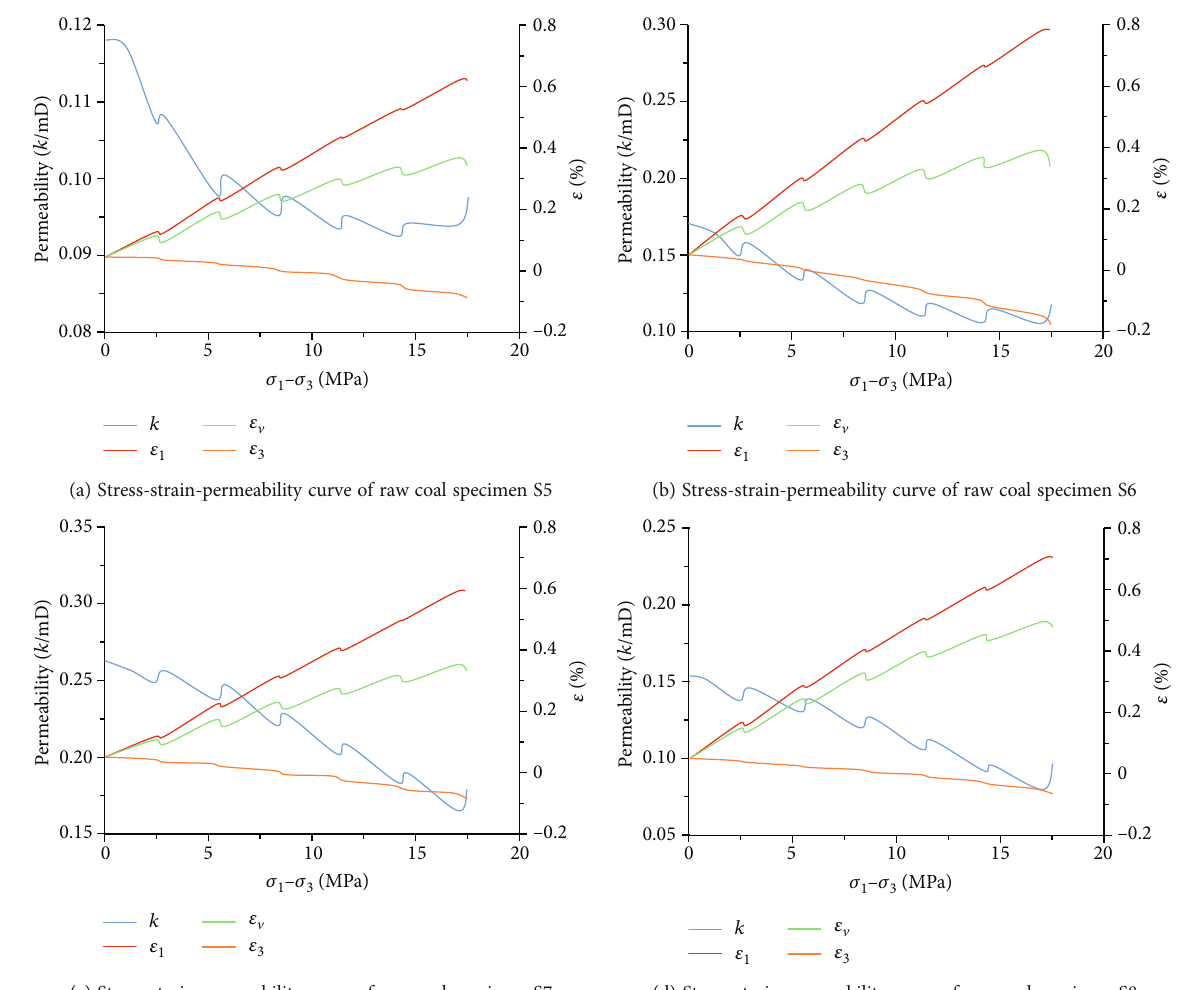
Figure 5: Stress-strain-permeability curve of raw coal under variable con fi ning pressure unloading rate